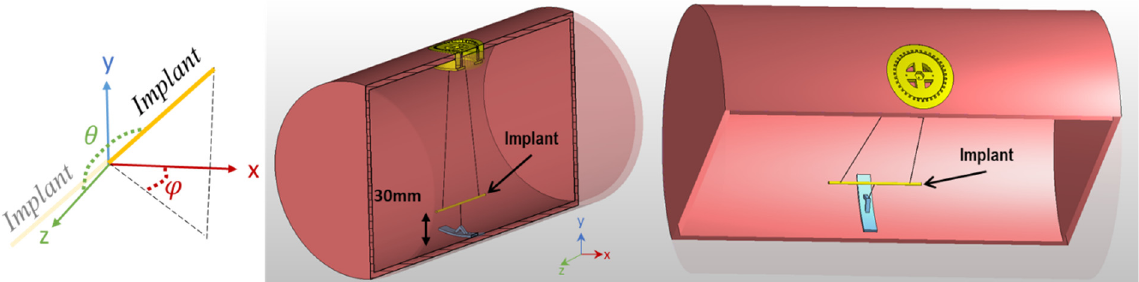
Figure 2. Cross section of the phantom and implant positioning system. The implant is suspended using cotton strings at a 30 mm distance from the phantom surface. The orientation of the implant can be controlled by adjusting the length of the strings and the rotation of the yellow implant adjuster positioned at the surface of the phantom. The orientations are defined based on a spherical coordinate system using polar ( θ ) and azimuthal ( ϕ ) angles when the origin is aligned with the center of the implant.